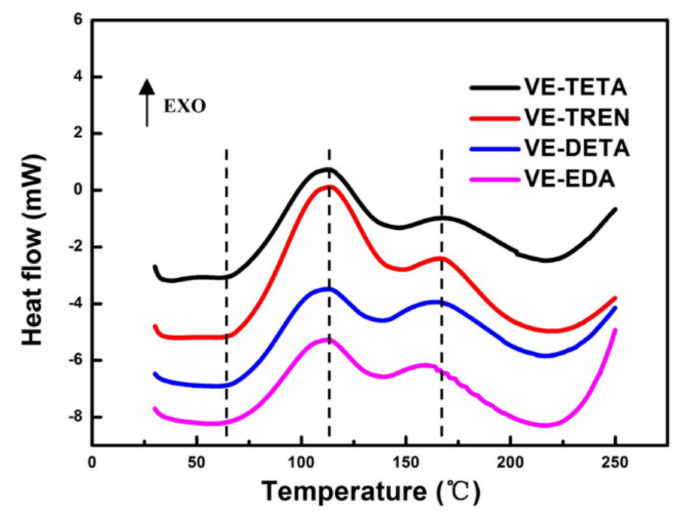
Figure 3. DSC curves of vanillyl alcohol–based epoxy with various curing agents.